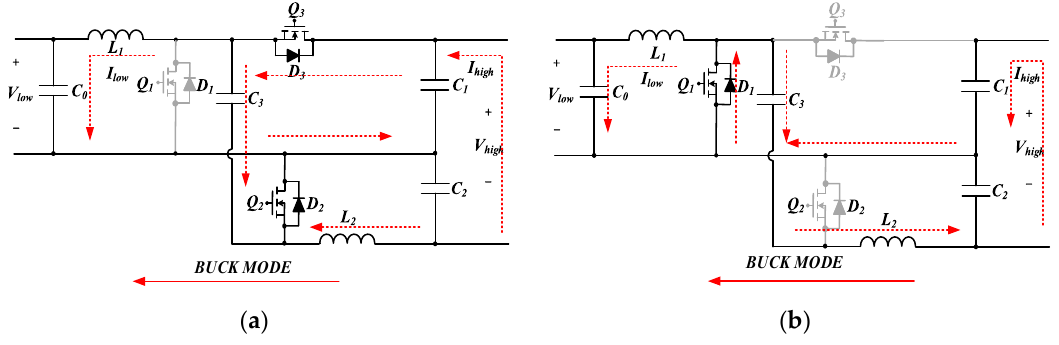
Figure 8. Topological states of converter II. ( a ) [ t 0 –t 1 ]. ( b ) [ t 1 –t 2 ].